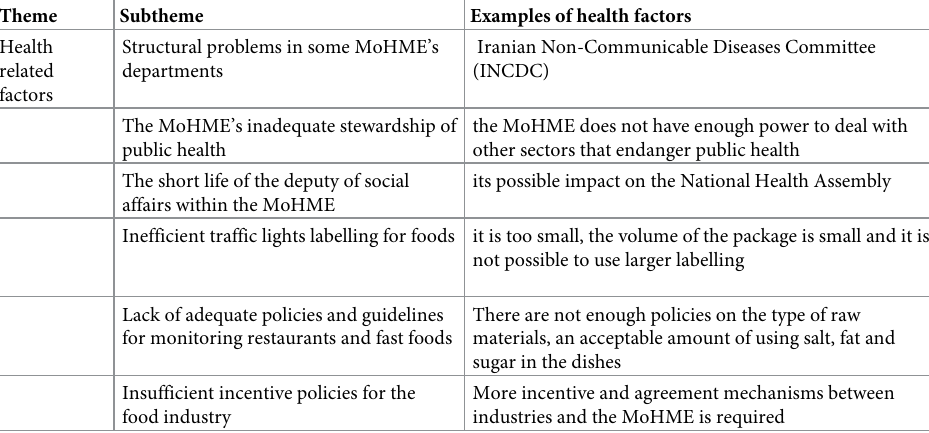
Table 2. Health-sector determinants of diet in